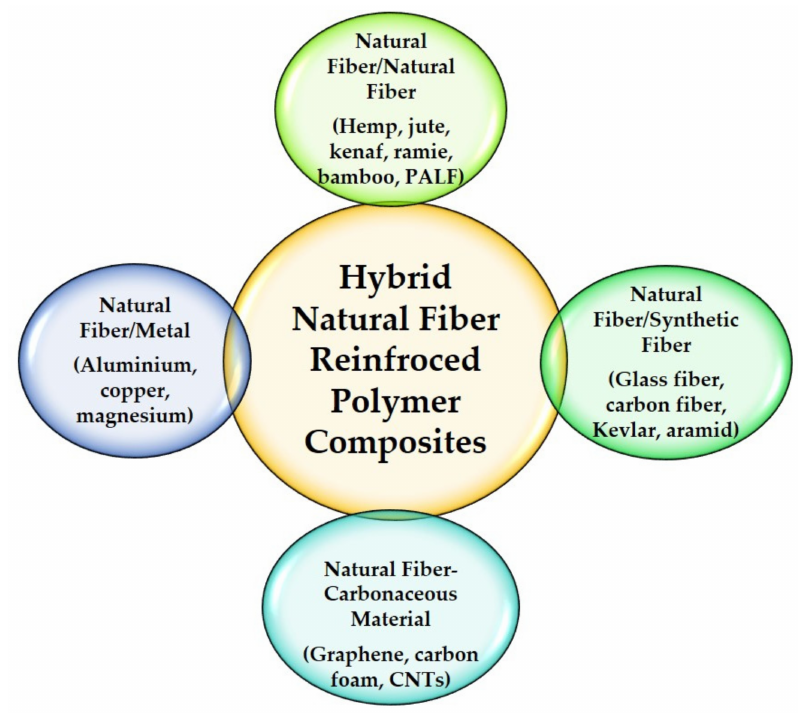
Figure 7. Summary for hybridization of natural fibers with other materials discussed in this section.